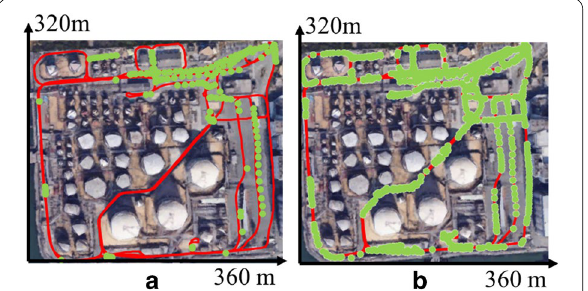
Fig. 14 Red denotes the robot trajectory and green is the GPS data in a Factory A. a GPS availability of 20.9%: RTK-Fix-GPS; b GPS avail- ability of 58.1%: RTK-Fix-GPS and RTK-Float-GPS